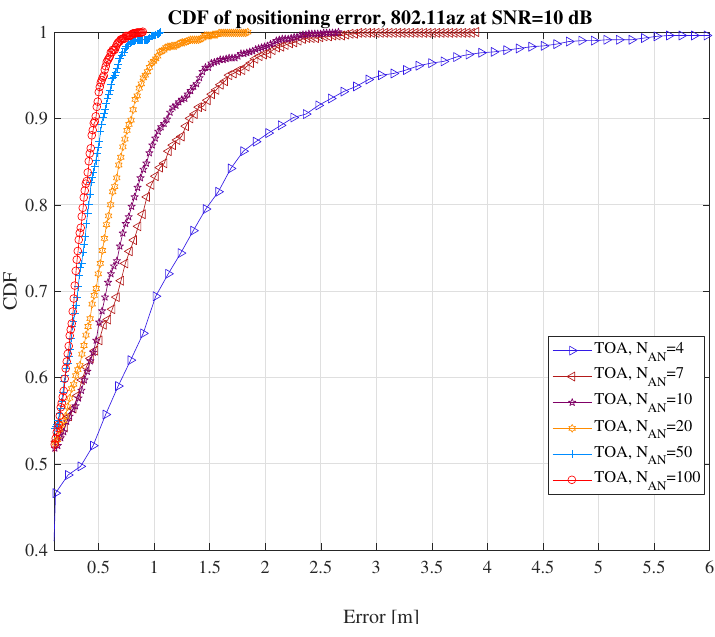
Figure 6. Example of 802.11az performance at various number of access nodes at signal to noise ration (SNR), SNR = 10